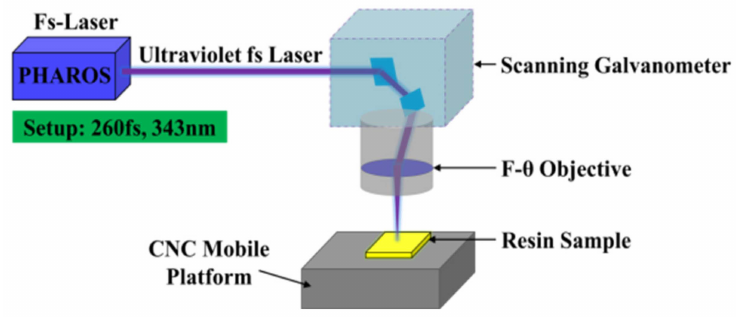
Figure 1. Schematic diagram of femtosecond laser processing